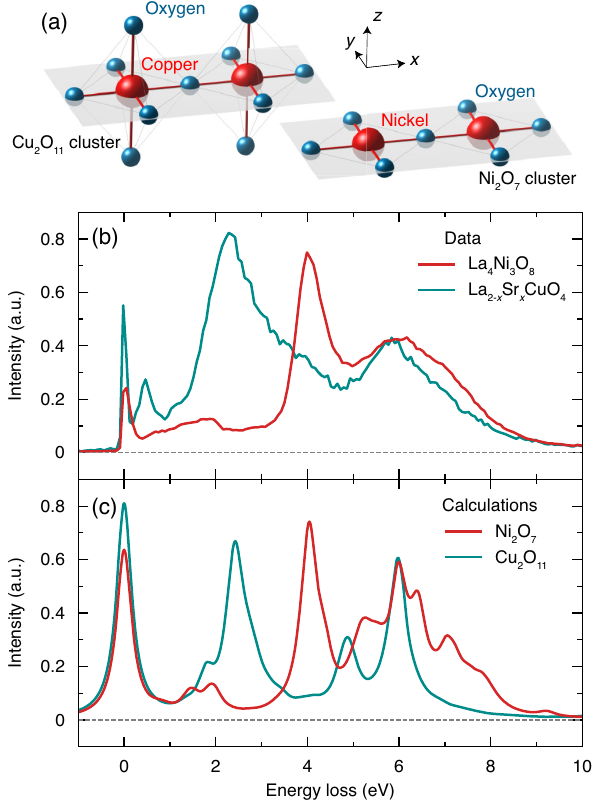
FIG. 3. Cluster exact diagonalization results. (a) Sketch of the Sr CuO 4 . x x clusters used in each case. (b) RIXS curves measured at the O prepeak resonance with θ ¼ 60 ° and σ polarization. The feature at 0.5 eV in the La 2 − Sr CuO 4 sample is known to come from a x x plasmon, so is not expected to appear in our model calculations [62]. (c) Calculated spectra using the parameters listed in Table I with the same experimental